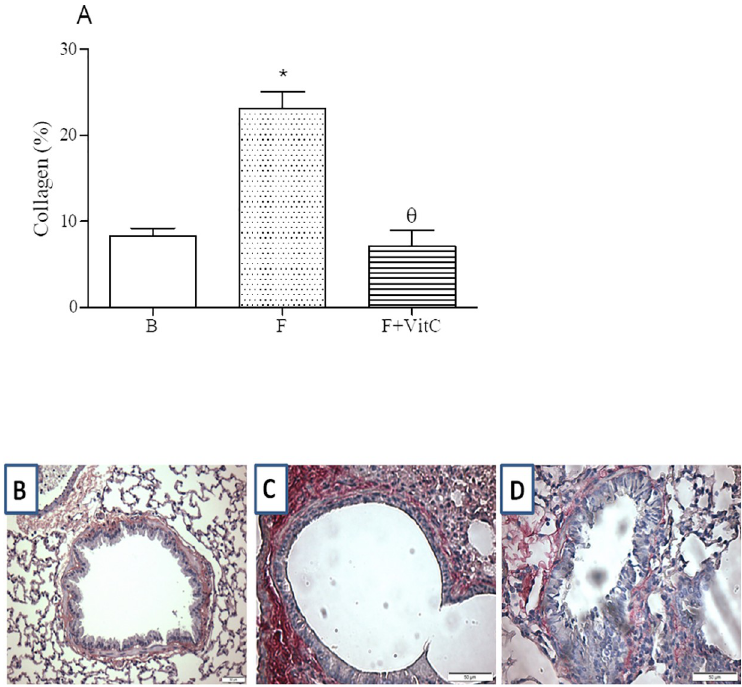
Fig 3. Vitamin C treatment reduces collagen deposition in the lung of PQ- induced fibrosis. Groups of mice were submitted to PQ or vehicle injection and after days the animals were treated with vitamin C or vehicle daily until day 14th. Twenty-four hours after the last treatment the collagen deposition was determined in the lung tissue. Data represent the mean ± SEM of 6 animals. � P < 0.05 in relation to B group ; θ P < 0.05 in relation to F group.